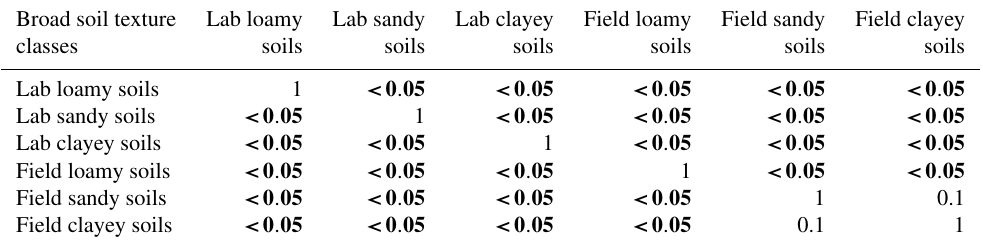
Table A1. Listed p values under 95 percent confidence interval for each class to show the significant difference in K sat between texture classes (see Fig. 3b). The significant difference was computed using ANOVA (analysis of variance) with post hoc Tukey’s HSD (honestly significant difference). The values in bold show the significant difference in K sat between two soil texture classes.